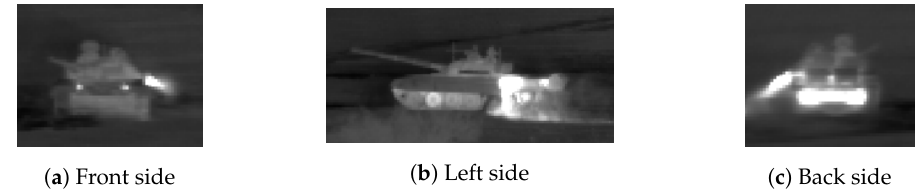
Figure 11. Examples of infrared signatures of a T72 main battle tank with regard to its